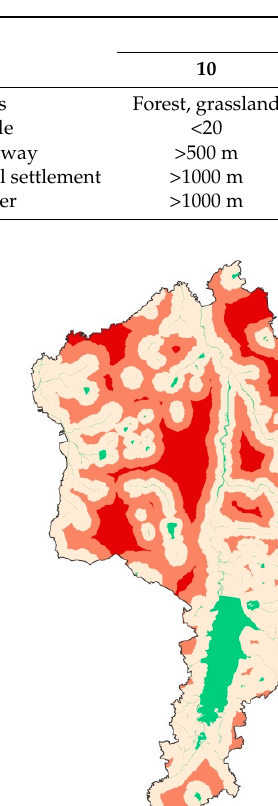
Table 3. Resistance coefficients and weights of resistance factors for species movement.